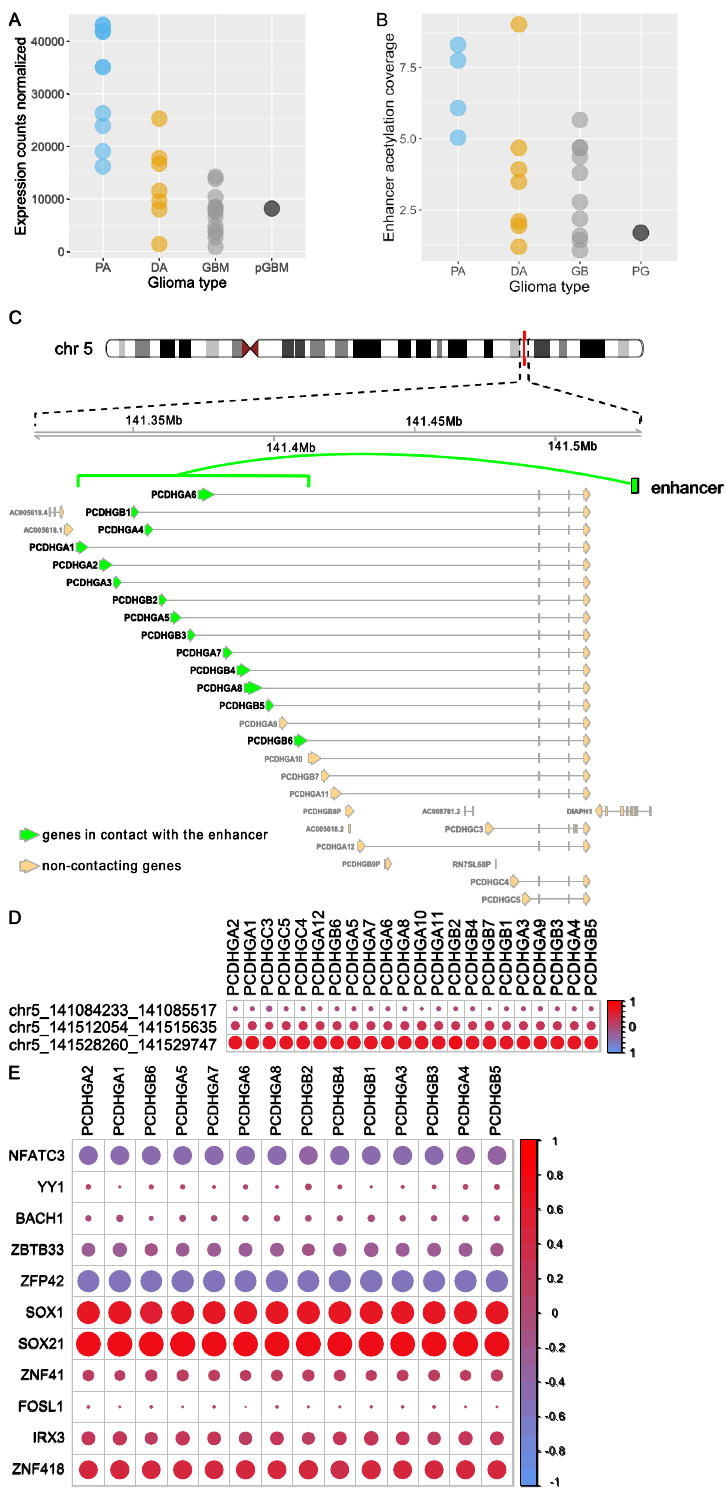
Figure 4. Regulation of PCDHGA gene cluster by H3K27 acetylation and/or DNA methylation of their contacting enhancers, as well as possible binding of transcription factors. ( A ) Expression of the PCDHGA2 gene (as an example of PCDHGA genes which had similar expression levels) across glioma grades. ( B ) H3K27 acetylation levels at the enhancer (chr5: 141528260– 141529747) contacting PCDHGA2 gene across glioma grades. ( C ) Visualization of contacts between PCDHGA genes cluster and contacting enhancer at chr5: 141528260–141529747. ( D ) Correlations between expression levels of PCDHGA genes and H3K27ac levels of their contacting enhancers. ( E ) Correlations between expression levels of PCDHGA genes and